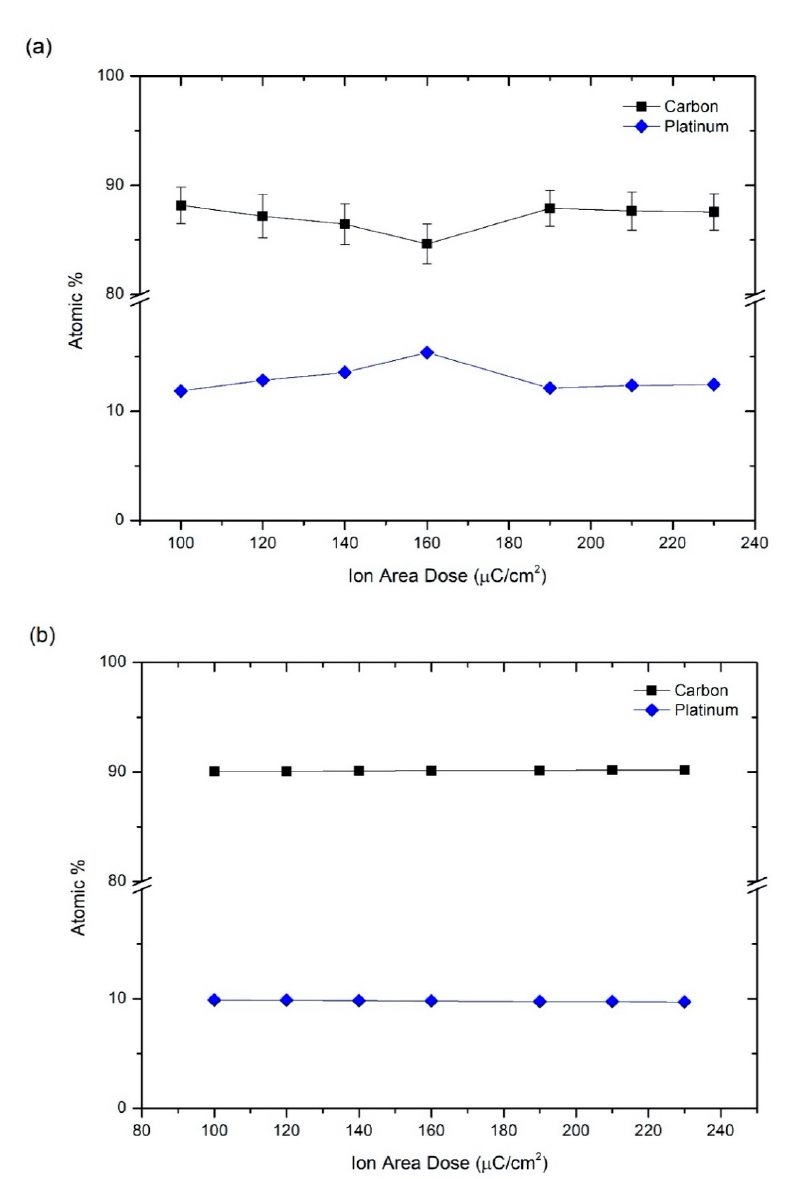
Figure 6. Atomic percentages as a function of the ion area dose of Pt-C cryo-deposits grown at 30 keV Ga + . ( a ) Experimental compositional results of deposits grown by Cryo-FIBID technique; ( b ) Compositional results extracted from Monte Carlo simulations at a depth of 15.25 nm.